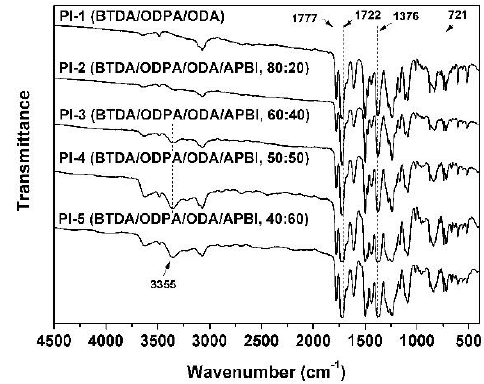
Figure 2. FT-IR spectra of PI coatings.